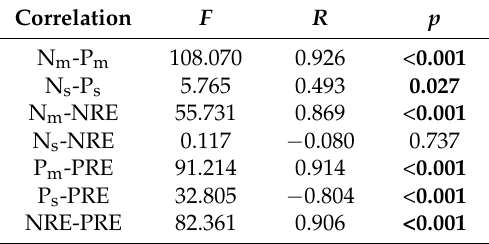
Table 2. Correlations between nitrogen (N) and phosphorus (P) concentrations, N and nitrogen resorption efficiency (NRE), P and phosphorus resorption efficiency (PRE), and NRE and PRE of A. corniculatum leaves.